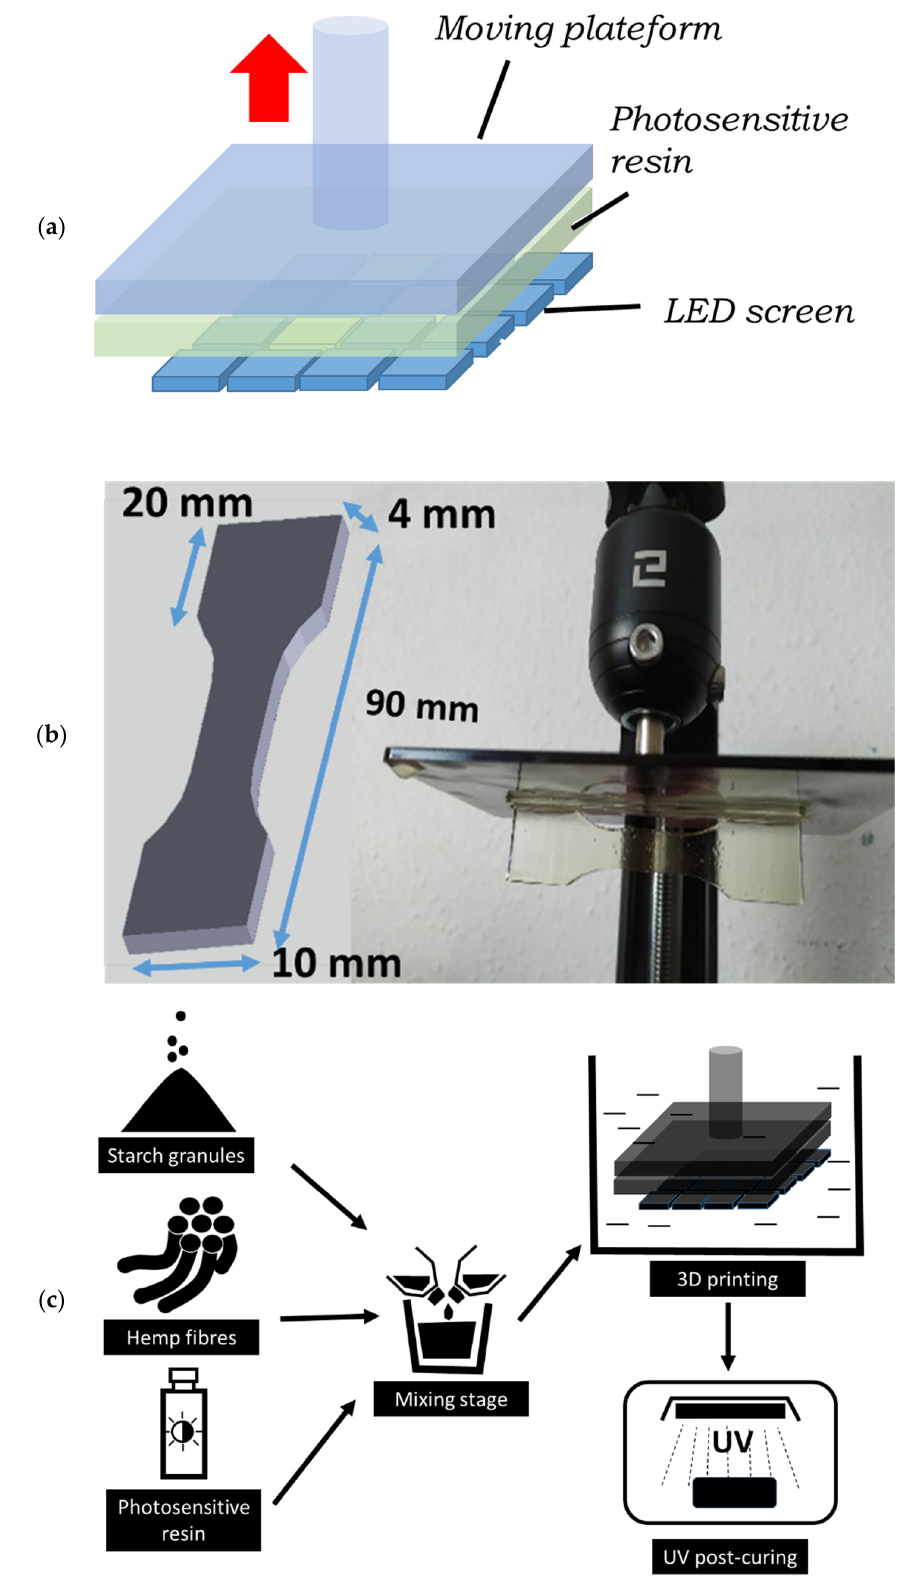
Figure 1. Digital light processing illustrated: ( a ) sketch describing the principle of DLP; ( b ) sample, dimensions, orientation, and printed dogbone sample using longer photosensitive resin; ( c ) illustrative sketch of the process preparation up to the post-treatment.